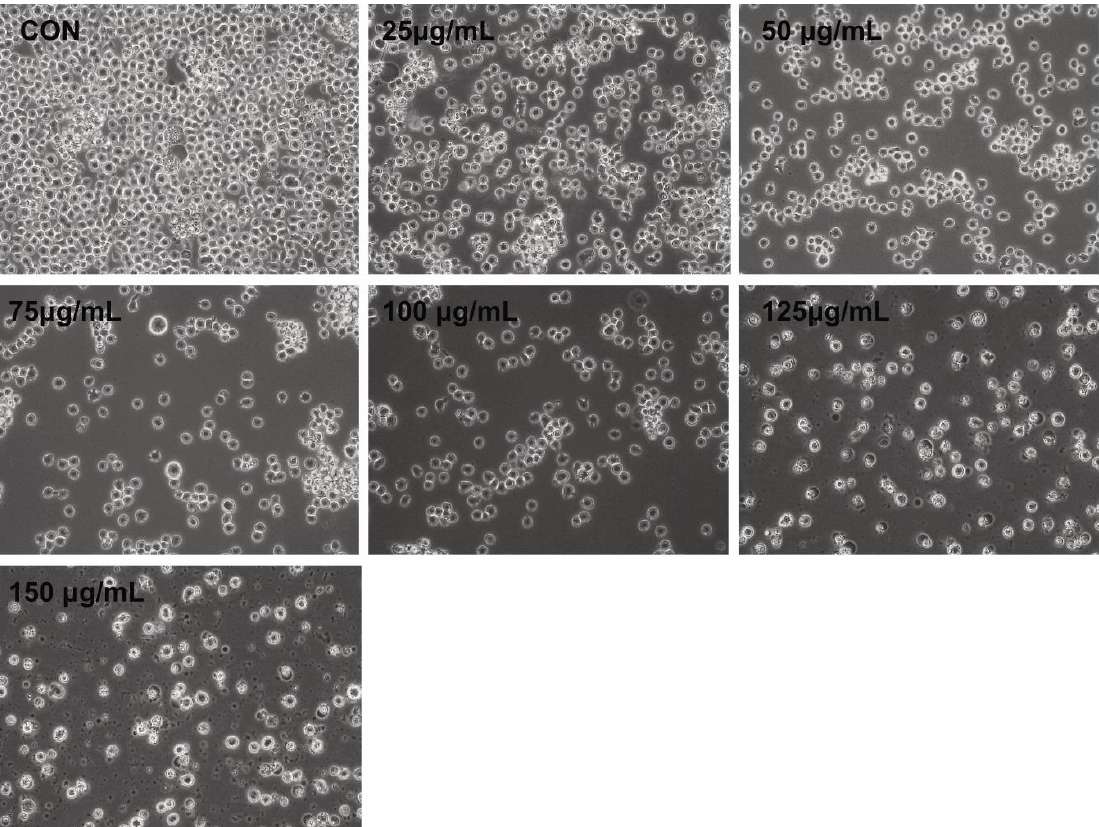
Figure 3 . PtNPs altered the morphology of THP-1 cells. The effect of PtNPs on cell morphology was determined after 24 h of exposure to different concentrations of PtNPs (25 – 150 µg/mL) using an optical microscope. At least three independent experiments were performed for each sample. Scale bar, 200 µm.